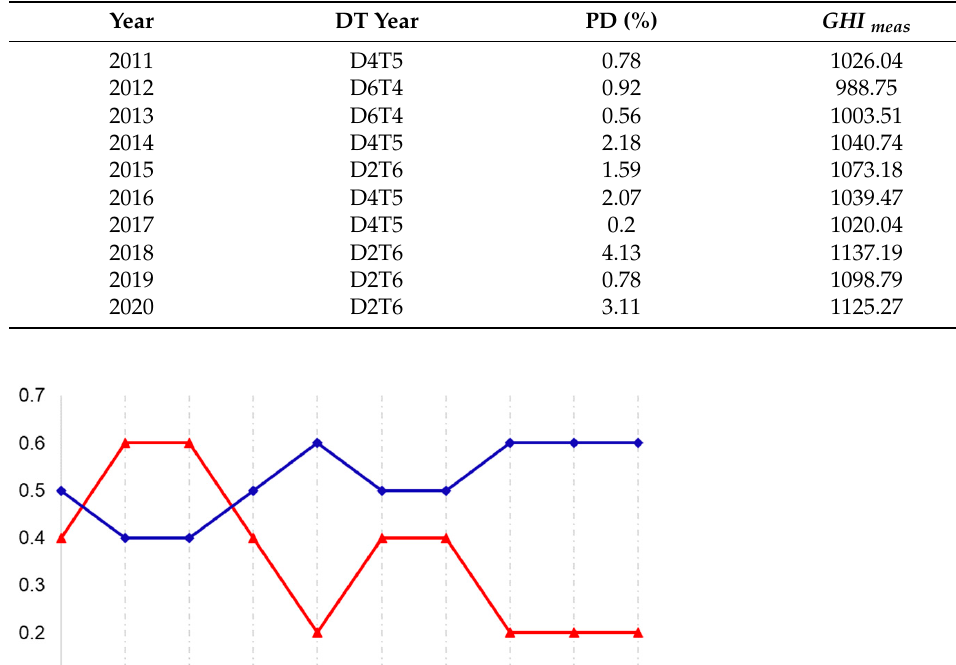
Table 2. Best fit DT values on an annual basis and the corresponding PD